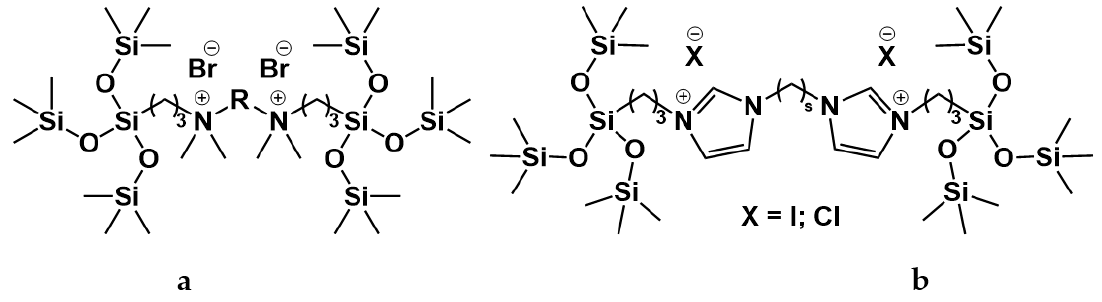
Figure 5. Chemical formulas of cationic tetrasiloxane gemini surfactants bearing ammonium ( a ) and imidazolium ( b )